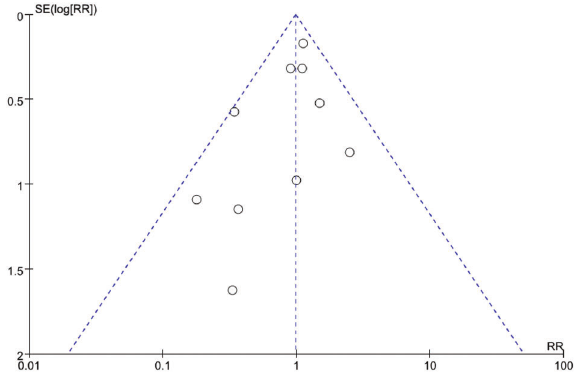
Figure 5. Funnel plot assessment of publication bias.